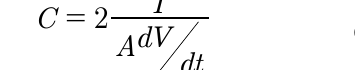
Figure 1. Schematic representation of supercapacitor assembly: PbI a polyester sheet separator between them, forming a flexible PbI and flexed